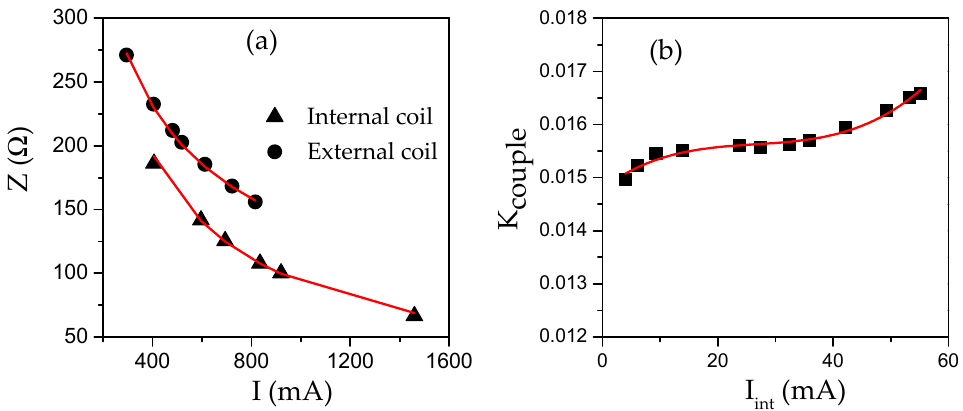
Figure 6. ( a ) Impedance of the internal and external coils. The external coil remains open circuit during the measurement of the internal coil and vice versa. ( b ) Coupling coefficient as a function of current in internal coil. Solid lines represent the approximation.